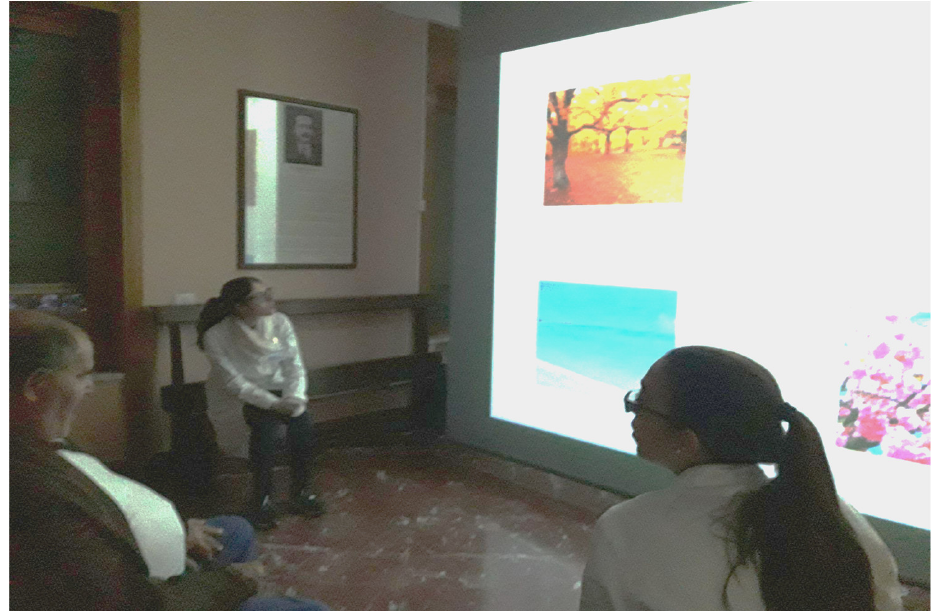
Figure 1. A patient undergoing VR training. The patient must recognize the seasons and operate with images, which emit sounds like the season in which he touches them (jingle bells for the winter). It is also asked to list the activities to be carried out in the various seasons and any recipes to be prepared with seasonal fruit (training for fluency and executive skills).